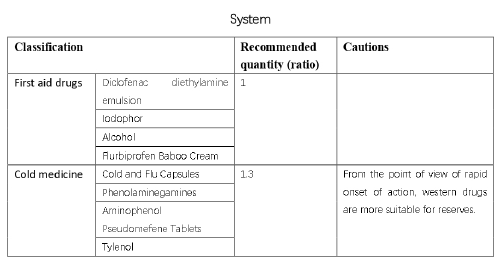
Figure 12. The initial version of the system.